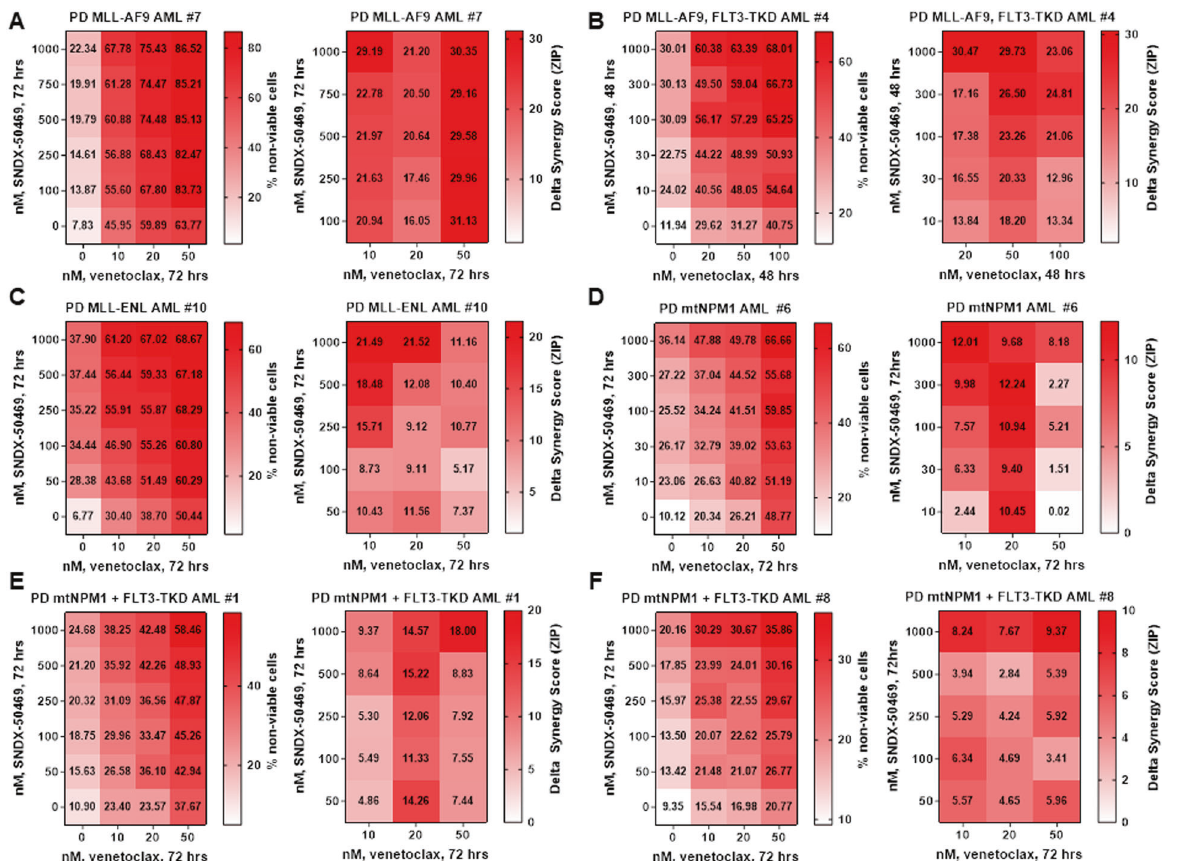
Fig. 5 Combined treatment with Menin inhibitor and venetoclax induces synergistic in vitro lethality in patient-derived AML cells expressing MLL1-r or mtNPM1 with or without FLT3 alterations. A – F Patient-derived AML cells with MLL1 rearrangement or mtNPM1 with or without FLT3 alterations were treated with the indicated concentrations of SNDX-50469 and/or venetoclax for 48 – 72 h. The % non-viable cells were determined by staining with TO-PRO-3 iodide and fl ow cytometry analysis. Delta synergy scores were determined by the ZIP method. Synergy scores > 1.0 indicate a synergistic interaction of the two agents in the